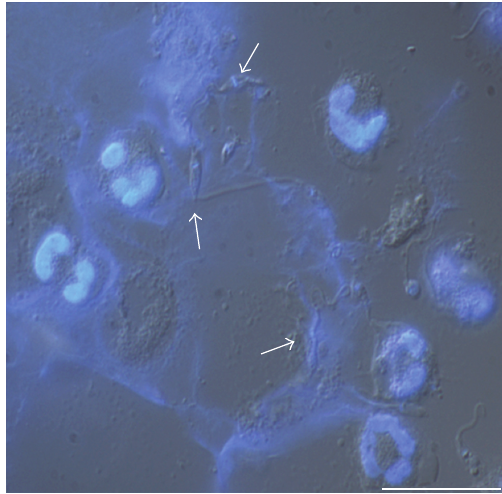
Figure 2: Immunostaining of NETs induced by Leishmania . Na ¨ ıve neutrophils were incubated with promastigotes (1:5 ratio) for 1 h at 35 ◦ C. Cells were fixed and stained with DAPI and shown merged with di ff erential interference contrast image. Arrows point to NET- ensnared promastigotes (Bars: 20 μ m).